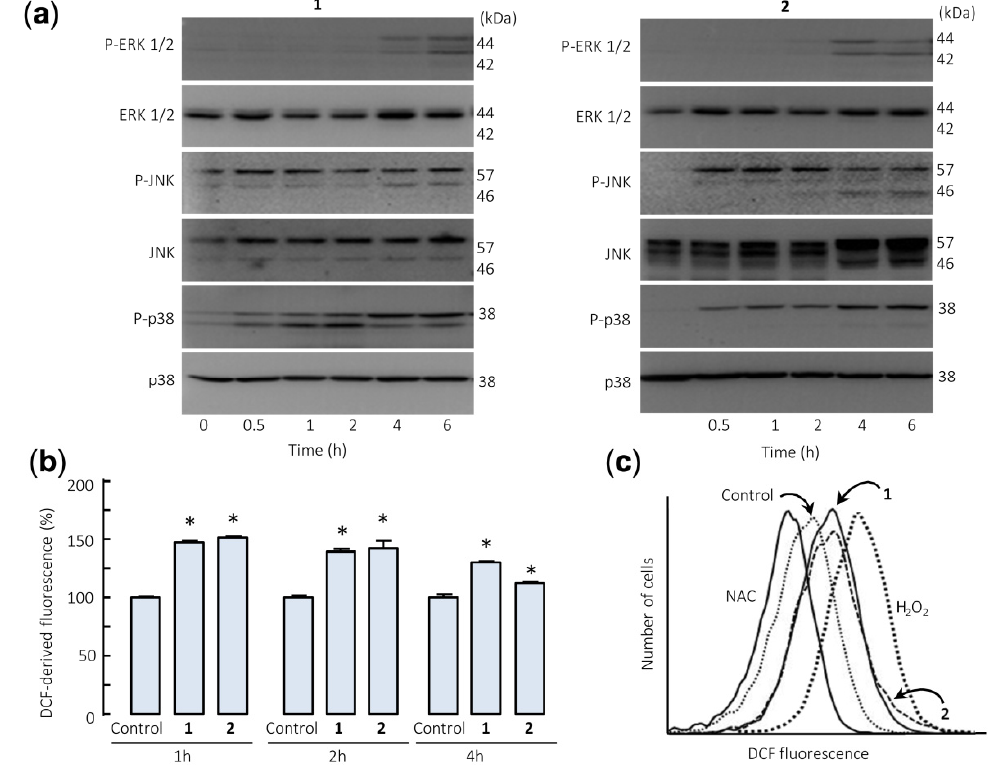
Figure 5. Sesquiterpene lactones induce phosphorylation of mitogen-activated protein kinases (MAPKs) and reactive oxygen species generation in U-937 cells. ( a ) Representative immunoblots show the kinetics of phosphorylation of MAPKs by the sesquiterpene lactones. Cells were incubated with the specified compound (30 µM) for the indicated times and protein extracts were prepared and analyzed by immunoblotting with specific antibodies. Blots were subsequently stripped and reprobed for the expression of total MAPKs, as indicated, to ensure equivalent loading and transfer of protein. ( b ) Cells were treated with compounds 1 or 2 (30 µM) for the indicated times ( b ) or for 1 h ( c ) and the fluorescence obtained by the oxidation of 2’,7’-dichlorodihydrofluorescein diacetate (H 2 -DCF-DA)